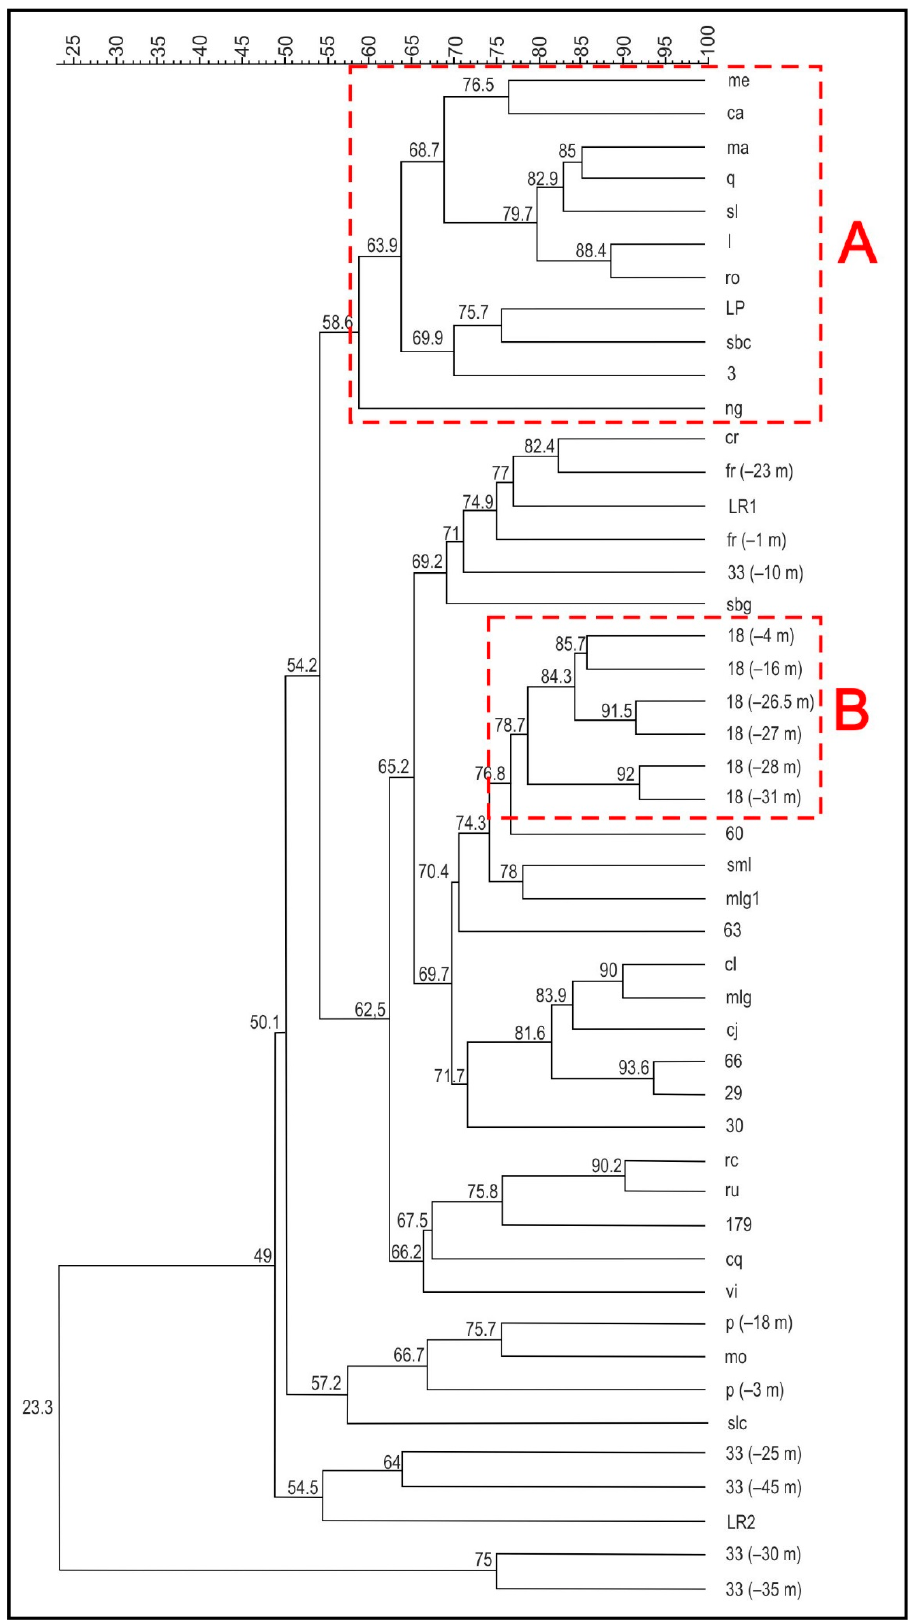
Figure 6. Cluster analysis of 16S rDNA polymerase chain reaction-denaturing gradient gel electrophoresis (PCR-DGGE) profiles from seawater, groundwater and surface water samples (Dice coe ffi cient with the UPGMA clustering algorithm). Similarity values are